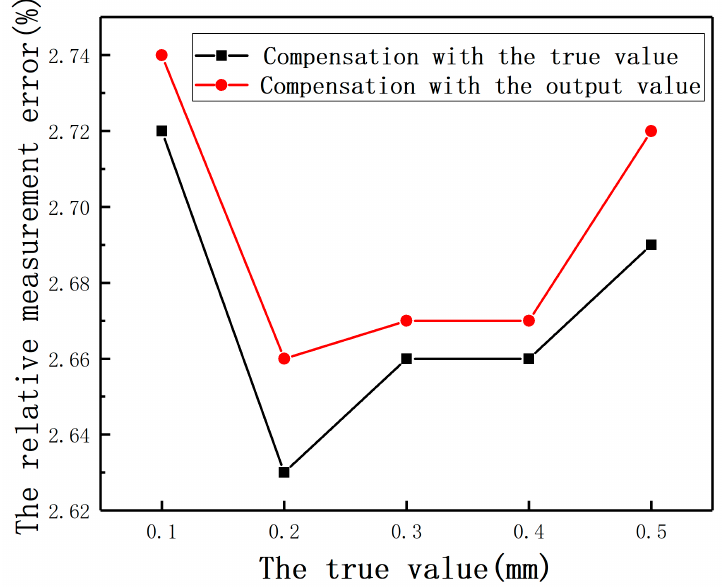
Figure 36. The relative measurement errors after compensation with the true value and the output value.